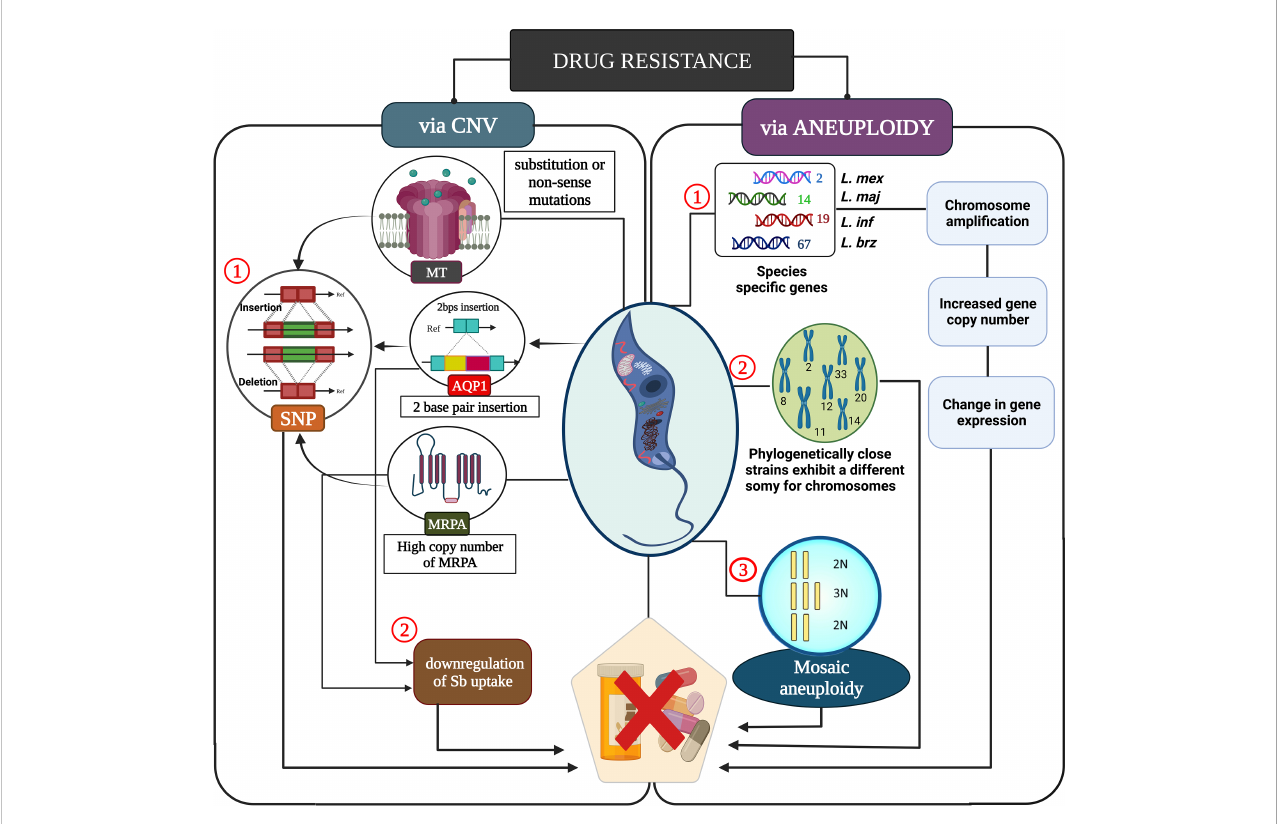
FIGURE 2 A molecular understanding of drug resistance caused by leishmanial parasite. Copy number variation in fl uences drug resistance through single nucleotide polymorphism which affects the Sb uptake, ultimately leading to drug resistance. Mosaic aneuploidy causes increased copy number variation which leads to chromosomal ampli fi cation thus modulating the gene expression in several members of leishmanial parasites for drug